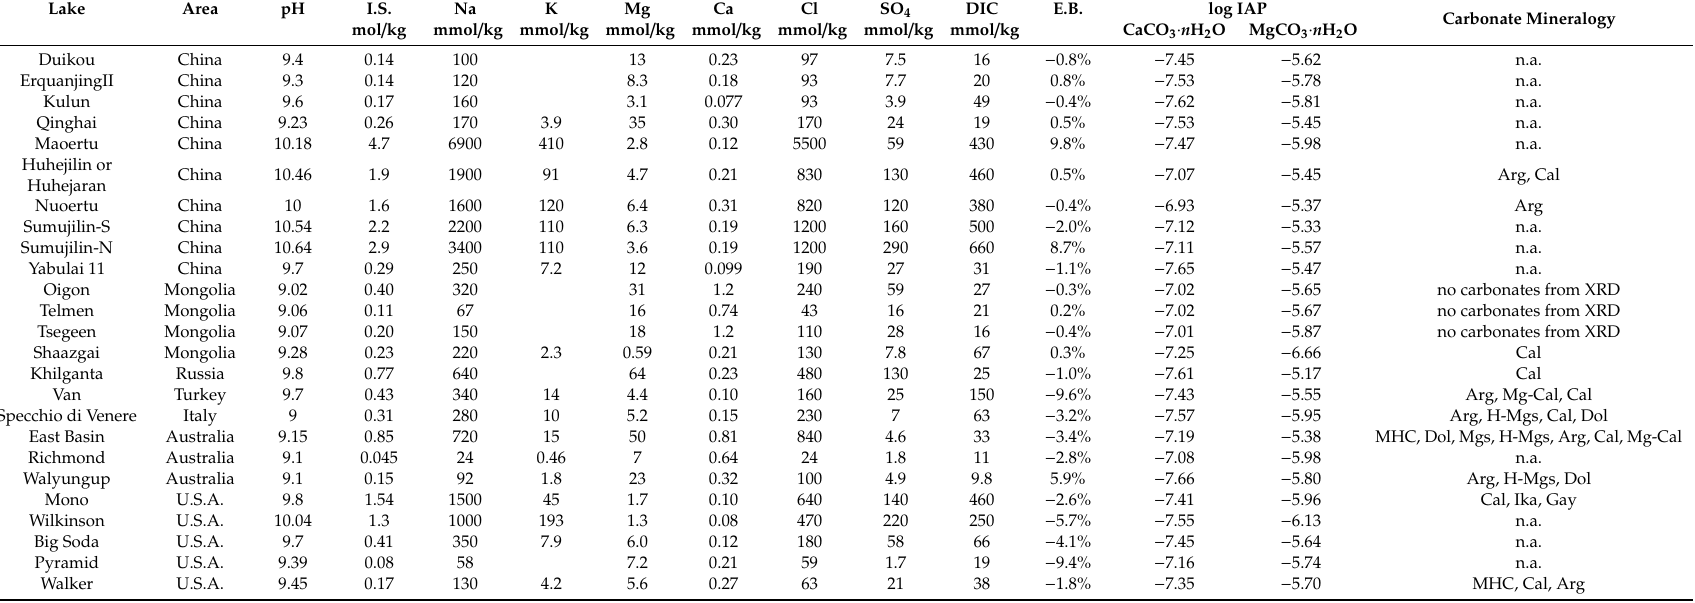
Table A1. Solution chemistries, electric charge imbalances (E.B.), and log ionic activity products (IAPs) with respect to CaCO 3 · nH 2 O and MgCO 3 · nH 2 O of alkaline lakes worldwide [13]. DIC, dissolved inorganic carbon; I.S. denotes ionic strength. “n.a.” indicates “not analyzed”. Mineral abbreviations: Arg, aragonite; (Mg-)Cal, (Mg-)calcite; Dol, dolomite; Gay, gaylussite; Ika, ikaite; (H-)Mgs, (hydro)magnesite; MHC, monohydrocalcite.